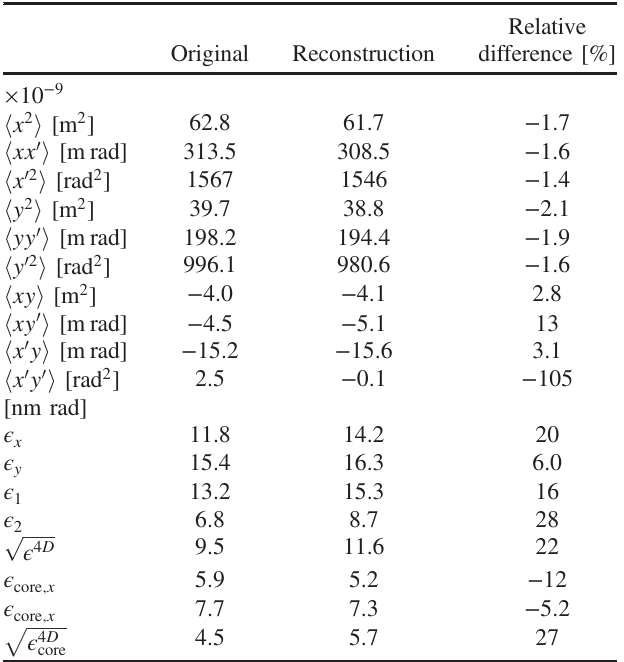
TABLE I. Beam matrix elements and the projected and intrinsic geometric emittances for the TEM grid